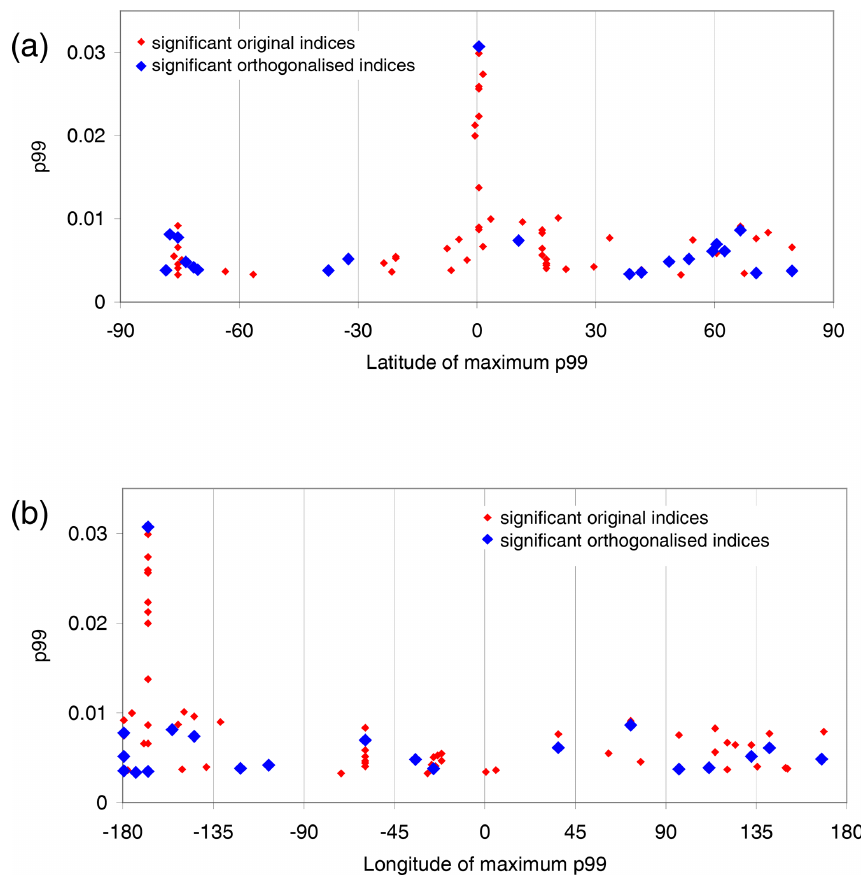
Figure 12. Location of the 99th percentile of the delta rms values detected in the TCWV data derived from satellite observations as function of latitude (a) or longitude (b) . Red points indicate results for the original indices, blue points for the orthogonalised